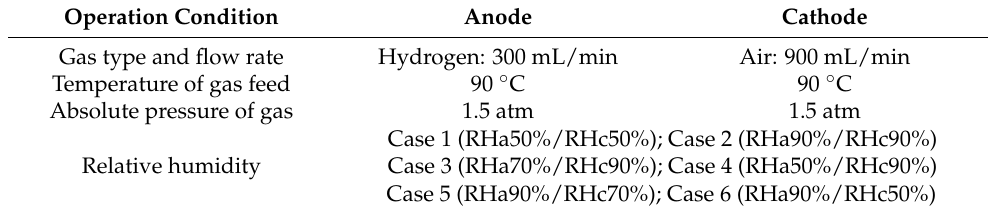
Table 2. Operating conditions during the tests.